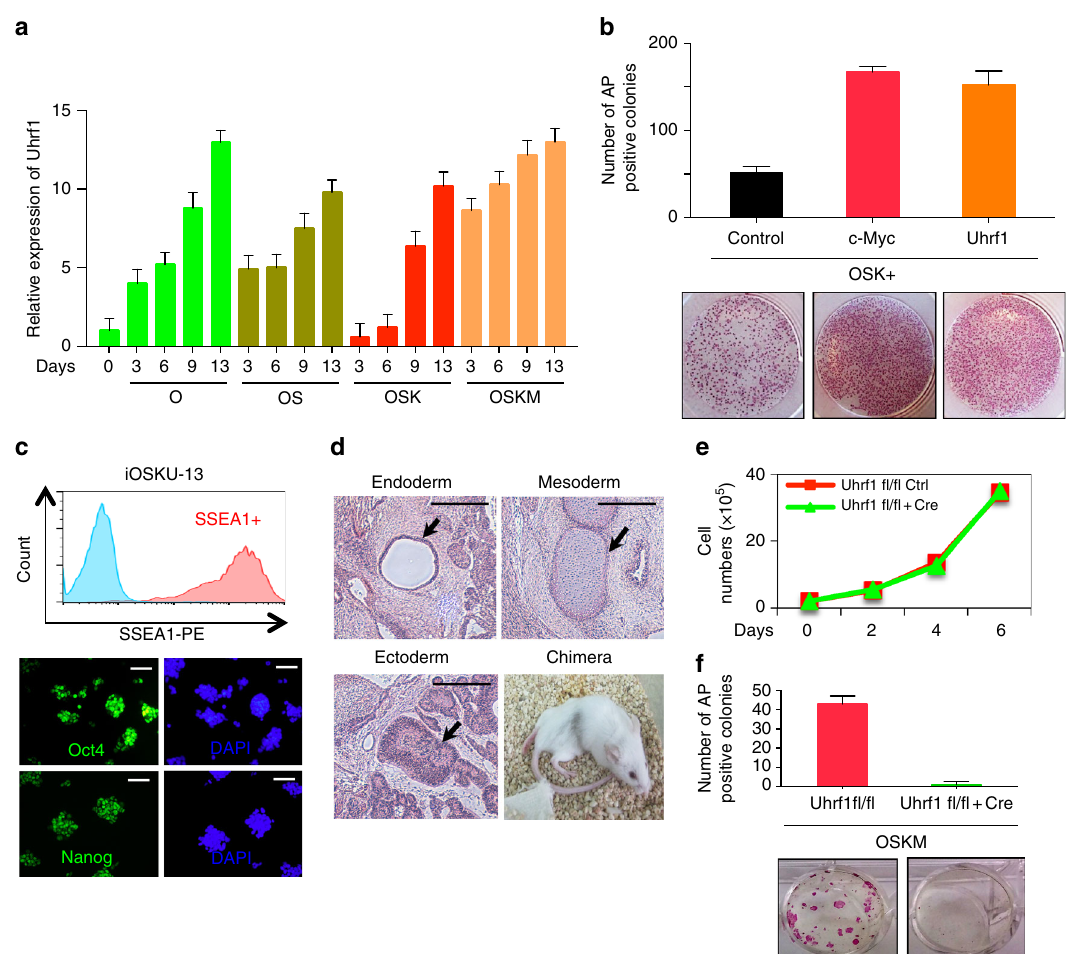
Fig. 4 Uhrf1 increases the reprograming ef fi ciency. a qRT-PCR analysis of Uhrf1 during reprogramming. Error bars represent mean ± s.d. b Ef fi ciency of iPSC colony formation was assessed by alkaline phosphatase (AP) staining after reprogramming. These are representatives of at least n = 3 experimental replicates. c Histogram of FACS fl ow of SSEA-1 and immunostaining images of Oct4, and Nanog of the iOSKU-13 obtained by reprogramming MEFs with Oct4, Sox2, Klf4, and Uhrf1. DAPI was used for counter-staining. The scale bar represents 4 mm. d Teratoma analysis showing tissues of three germ layers (respiratory epithelium for endoderm, cartilage for mesoderm, and neural tissue for ectoderm) and chimera generated from iOSKU-13 iPSC line. The scale bar represents 4 mm. e , f MEFs isolated from Uhrf1 fl / fl mice were treated with Cre-retrovirus. Uhrf1 KO MEF cells were used for cell proliferation assay ( e ) and reprogramming ( f ). The number of AP + iPSC colonies was analyzed. The data in e – f represent as n = 3 experimental